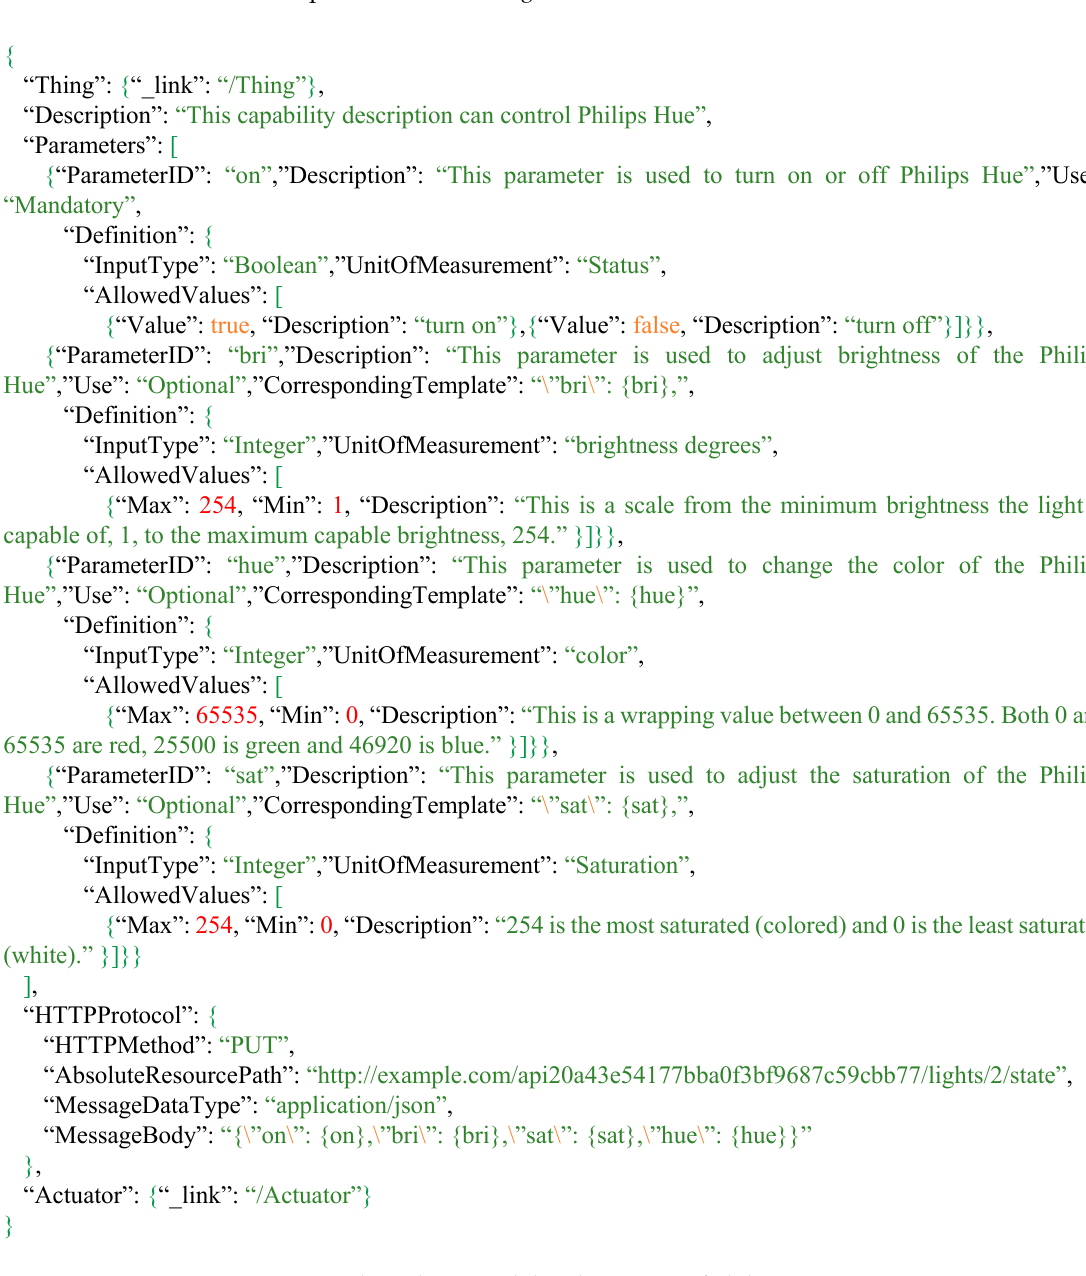
Figure 9. The tasking capability description of Philips Hue.